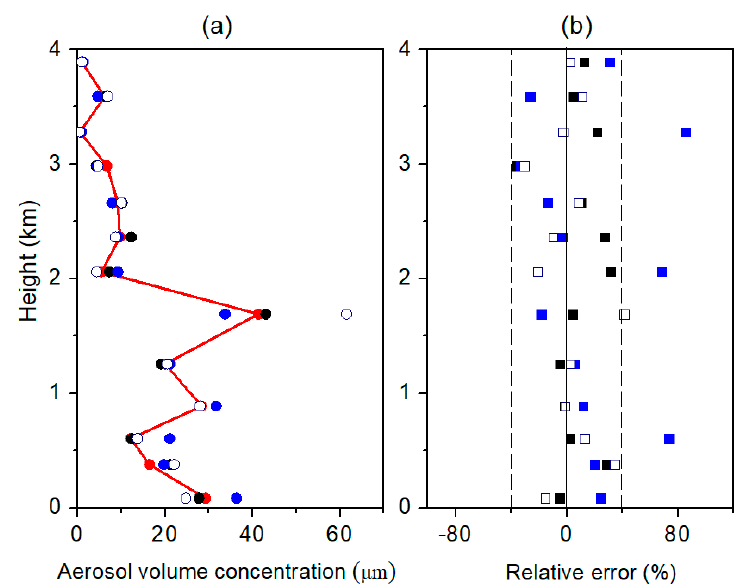
Figure 9. ( a ) Measured aerosol volume concentration, inversion volume concentration and ( b ) the corresponding relative error at the vertical heights.